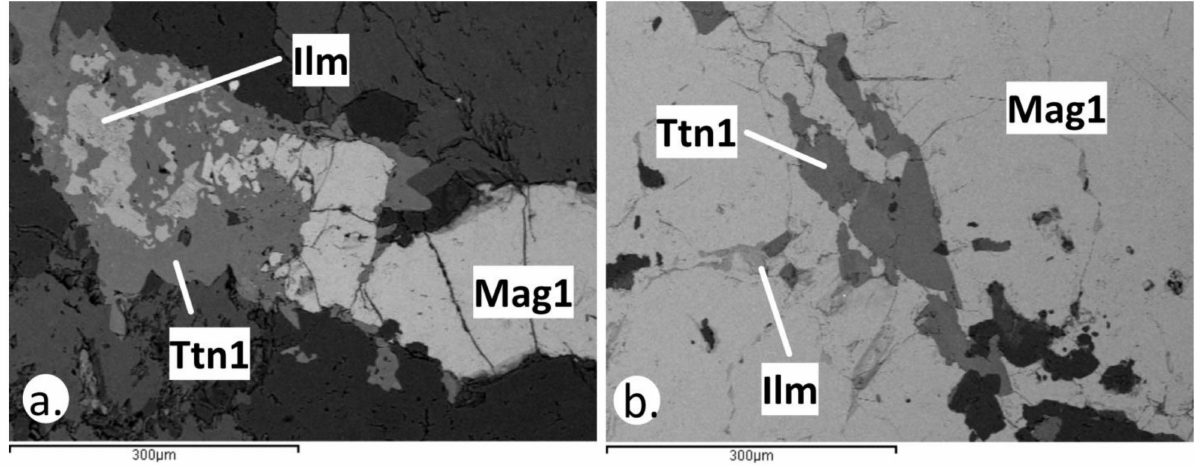
Figure 8. SEM back-scattered electron images of magnetite and titanite from different mineralization stages from the potassic-calcic alteration of the quartz monzonite ( a , b ): ( a ) disseminated magnetite (Mag1) is intergrown with titanite (Ttn1) and ilmenite (Ilm); ( b ) massive magnetite (Mag1) including titanite (Ttn1) and ilmenite (Ilm) in M-type